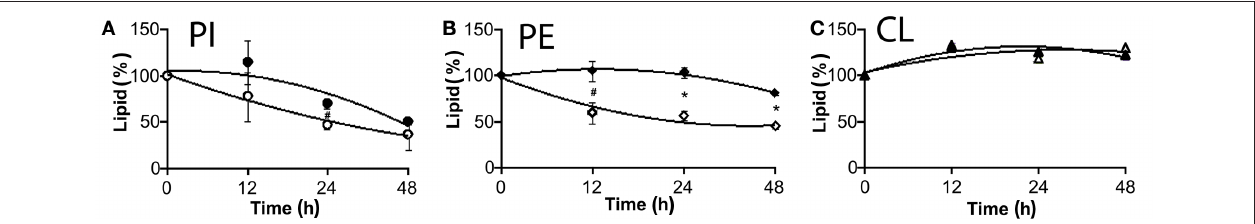
(A) represents changes in the level of PI, (B) PE, and (C) CL. Data are presented as percentage of total lipids, relatively to time zero. Values were obtained from two independent experiments in duplicate. The star represents P < 0.02 and hash P < 0.05 ( t -test method). The values represent averages and bars indicate the SD.